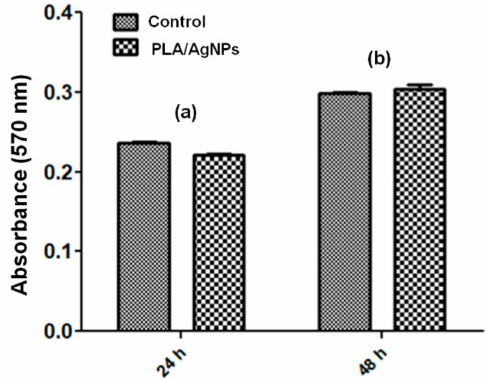
Figure 6. Viability results of human endothelial cells cultured for 24 h ( a ) and 48 h ( b ) on composite PLA / AgNPs coatings using the MTT assay (n = 3, * p <